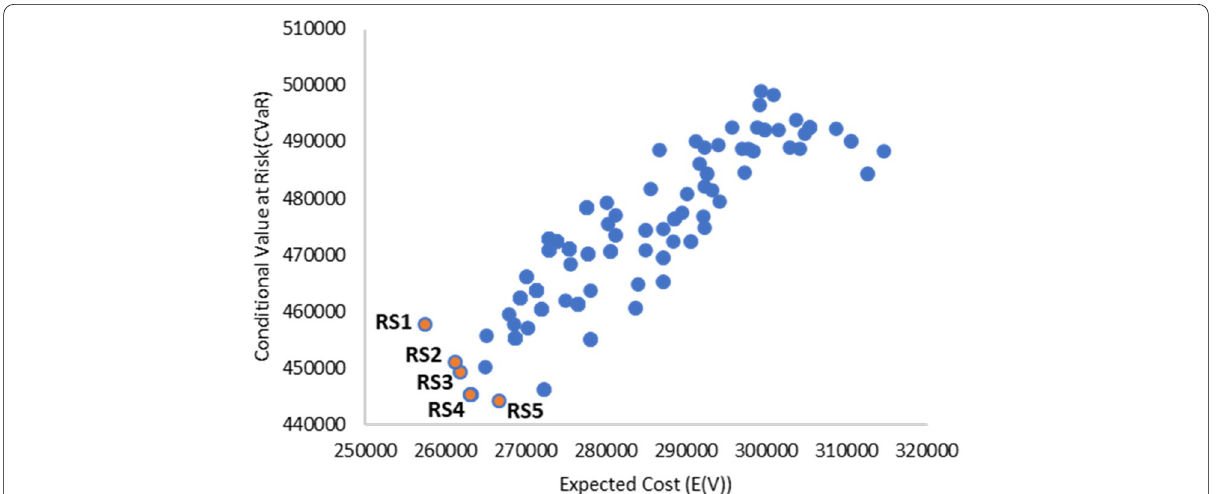
Fig. 8 Expected cost and Conditional Value at Risk for different rehabilitation policies obtained during the progression of simulated annealing